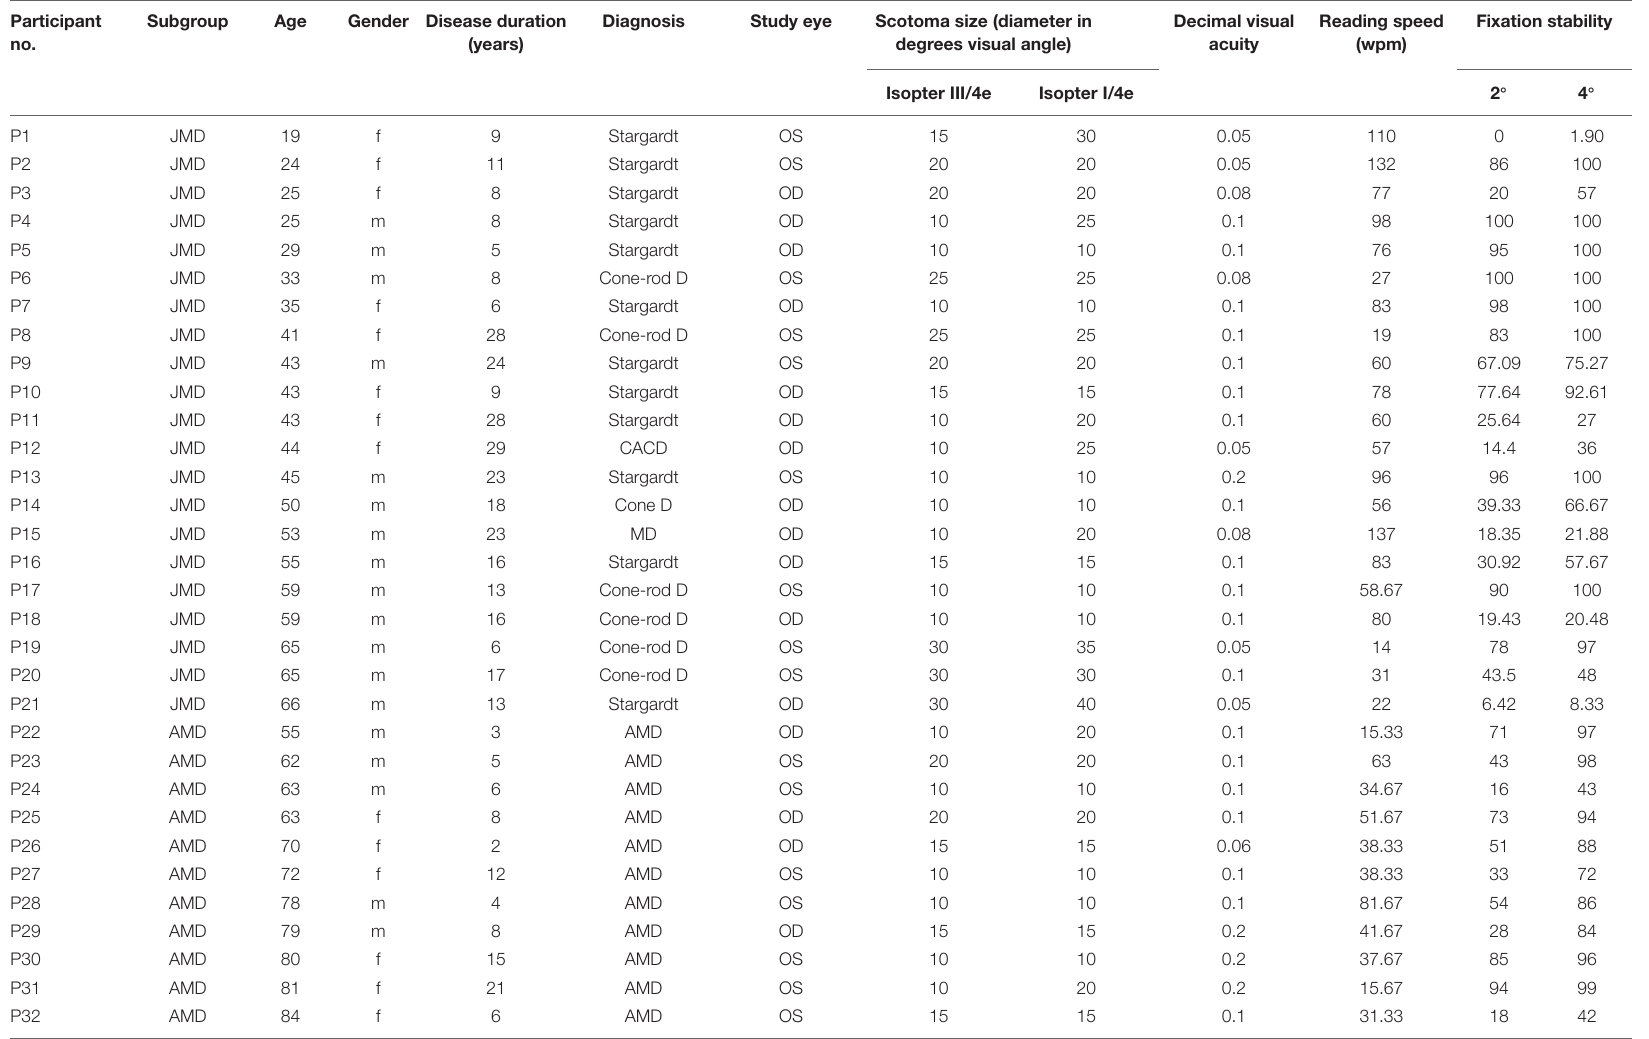
TABLE 1 | Characteristics of patients (P1–P32) and controls (C1–C32) according to age, gender, and (for the patient group only) duration of disease in years, diagnosis, study eye, scotoma size (rounded diameter in degrees visual angle), decimal visual acuity, reading speed (in words per minute), and fixation stability (percentage of fixation in 2 and 4 degrees visual angle around fixation target). Participant